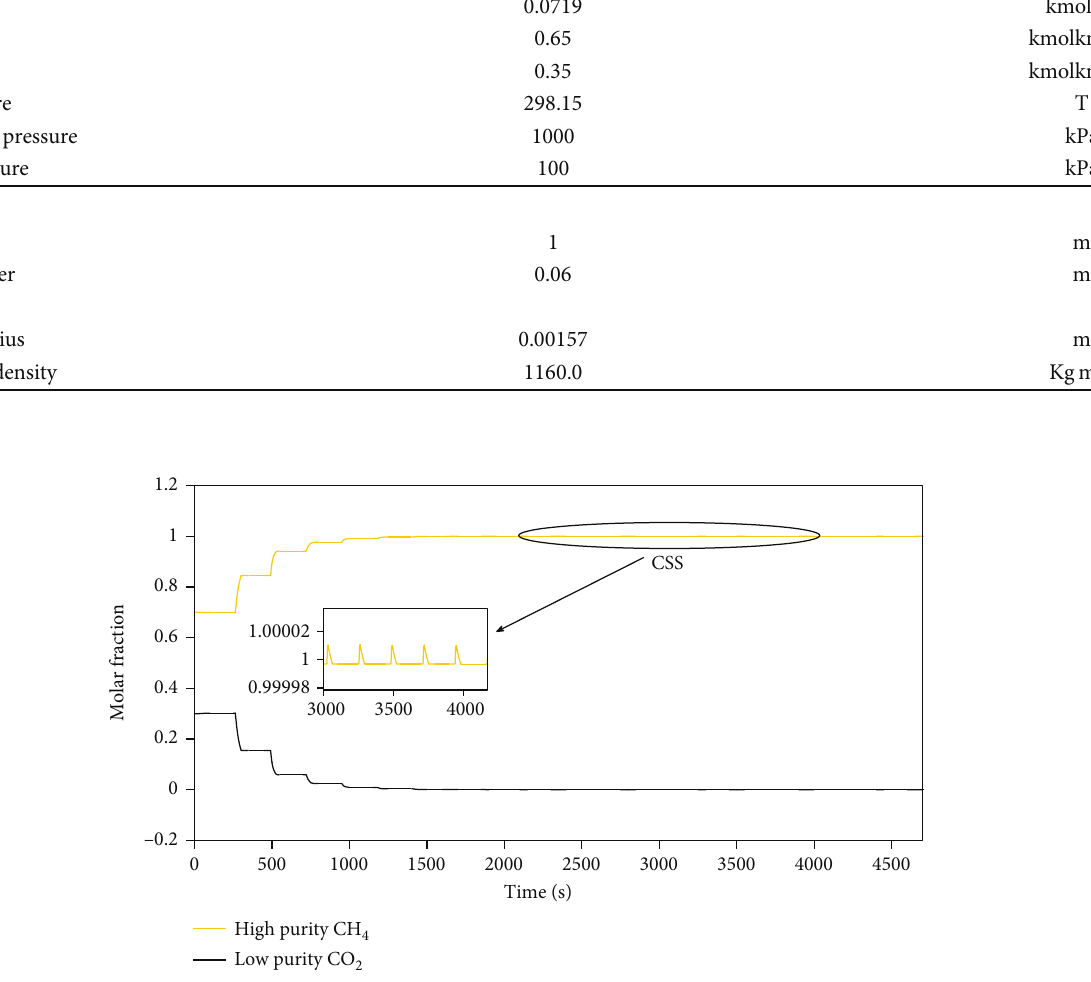
Figure 13: Puri fi cation and production of biomethane from the